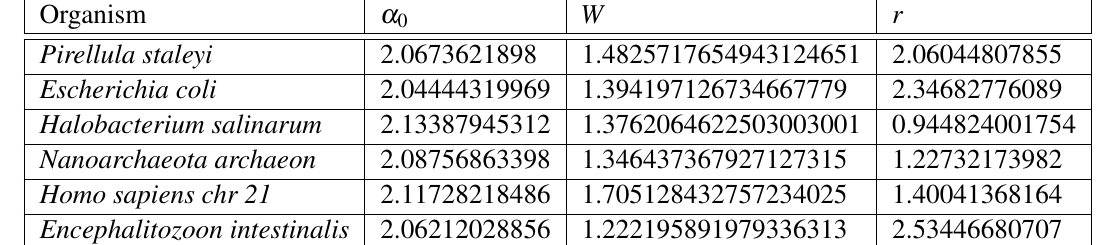
Table 1 Relevant parameters of multifractals of Fig. 6 : the value of α where the maximum value occurs α 0 , the wide of spectrum W and the spectrum skew shape r